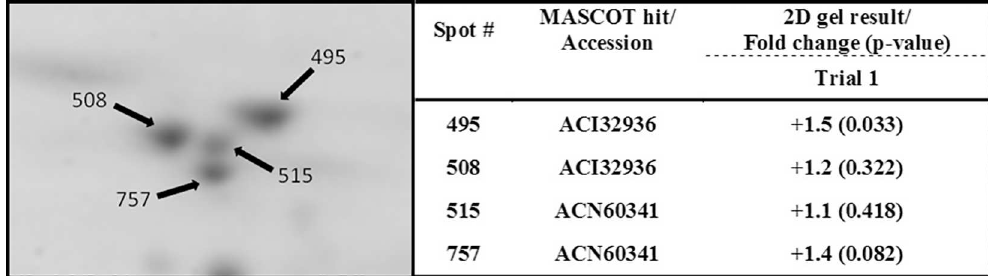
Fig 2. Magnification of the gel image in the area where the calreticulin spot (no.757) was located in Fig 1. The table indicatesthe identities the other protein spots migrating in this regionof the profile along with their fold- changeand p-value from the SameSpotsanalysisof mucus samples from